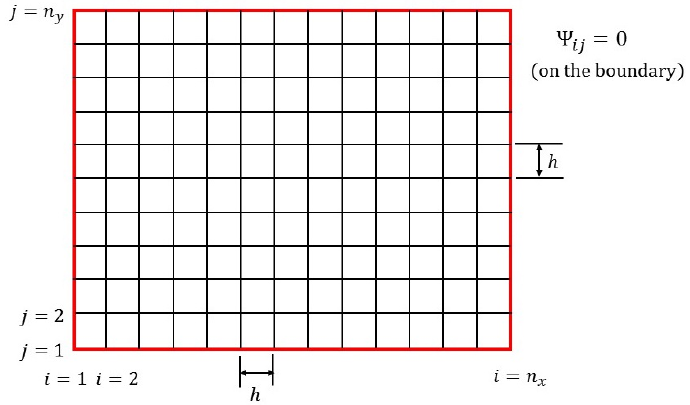
Figure 2. Typical Cartesian mesh used for the lid-cavity flow. (Reproduced with permission from [21]).